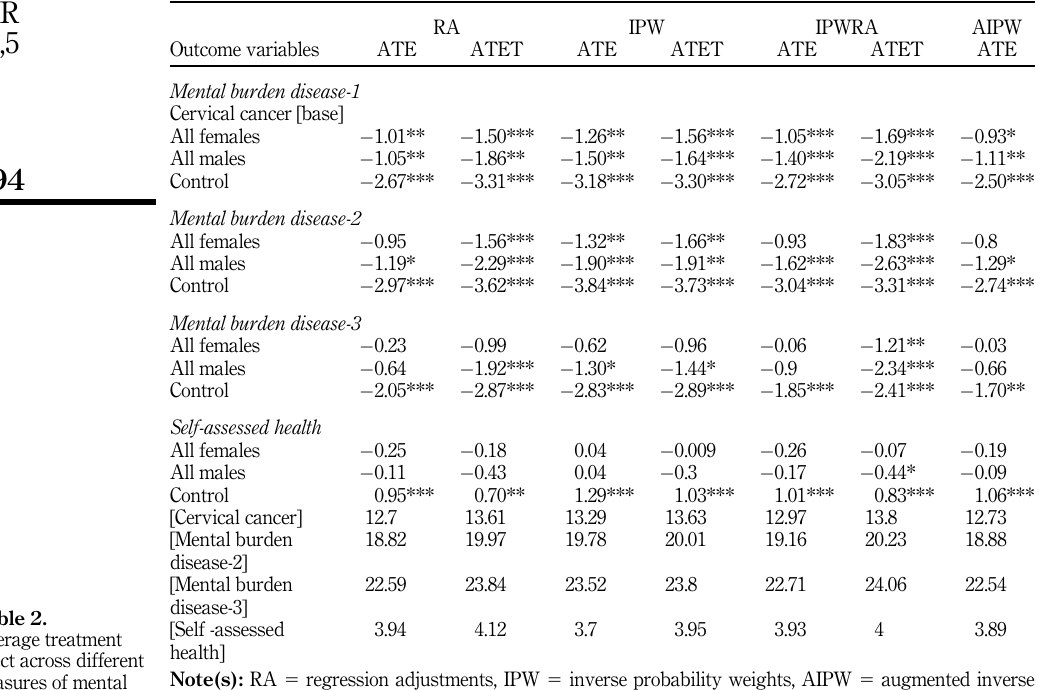
Table 2. Average treatment effect across different measures of mental burden (multiple treatment